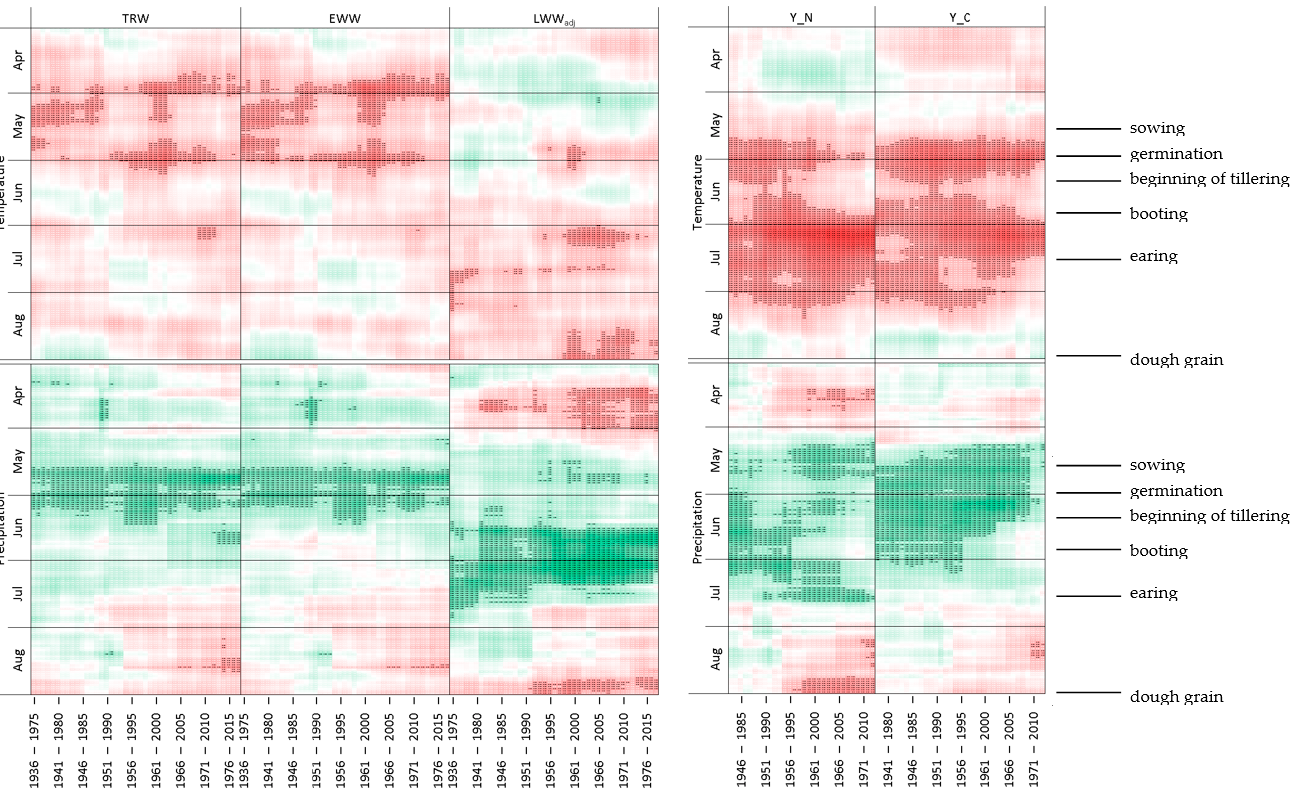
Figure 4. Dynamics of the climatic response (moving correlation coefficients with 21-day series of temperatures and precipitation, window 40 years, step 1 year) of the larch radial growth parameters and zonal grain crops yield. Significant correlations at p < 0.05 are marked. The average dates of the cereal phenophases marked on the right are given according to the observations of the Karatuz variety-testing station for 2015–2019. Sign of the correlation is marked with color (positive—green, negative—red).